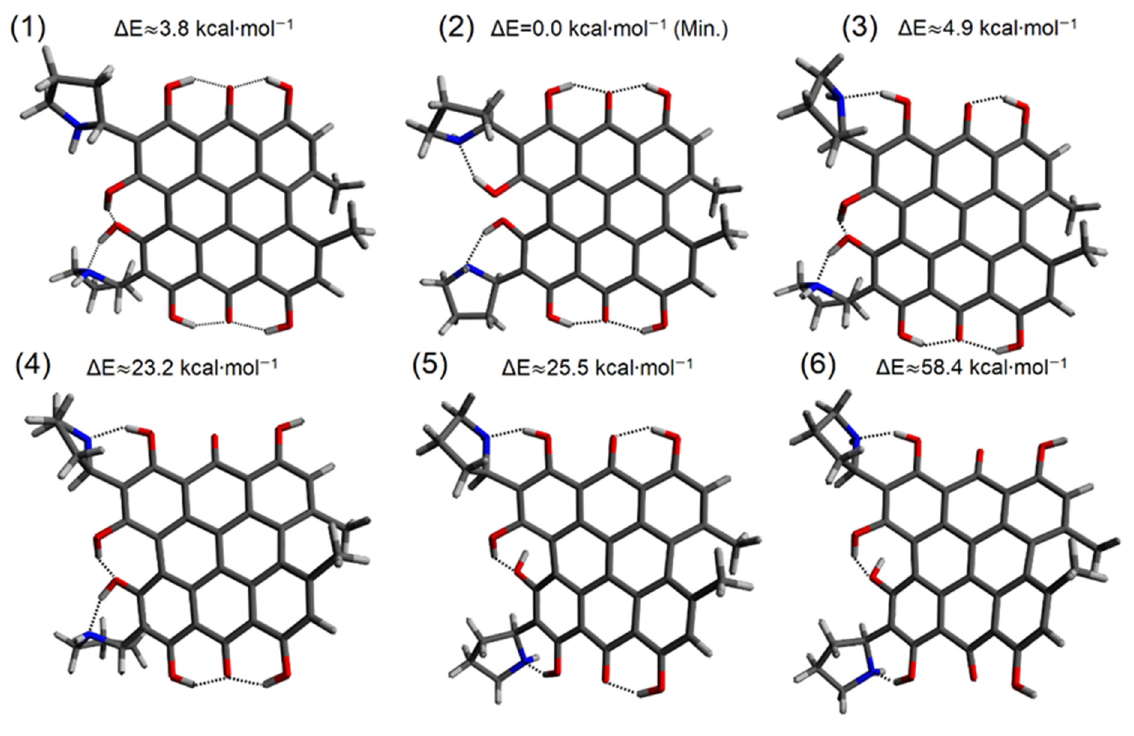
Figure 1. Conformers ( 1 – 6 ) of fagopyrin A.